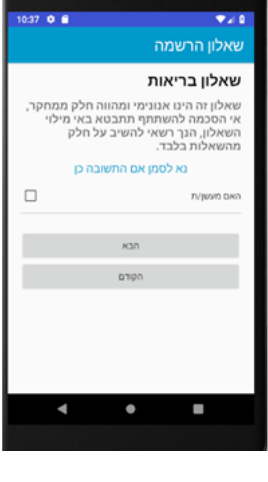
Figure 8. Registration questionnaire screen for the patient: general